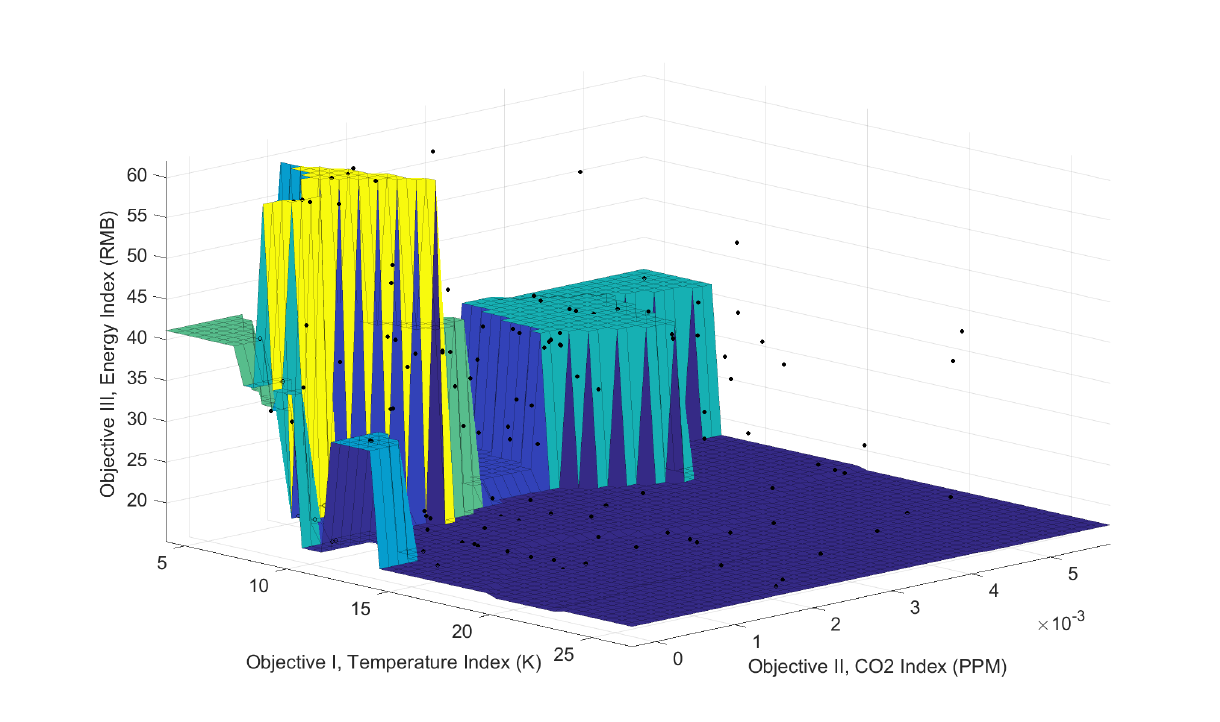
Figure 11. Fitting surface of optimal solutions using nearest neighbor method.